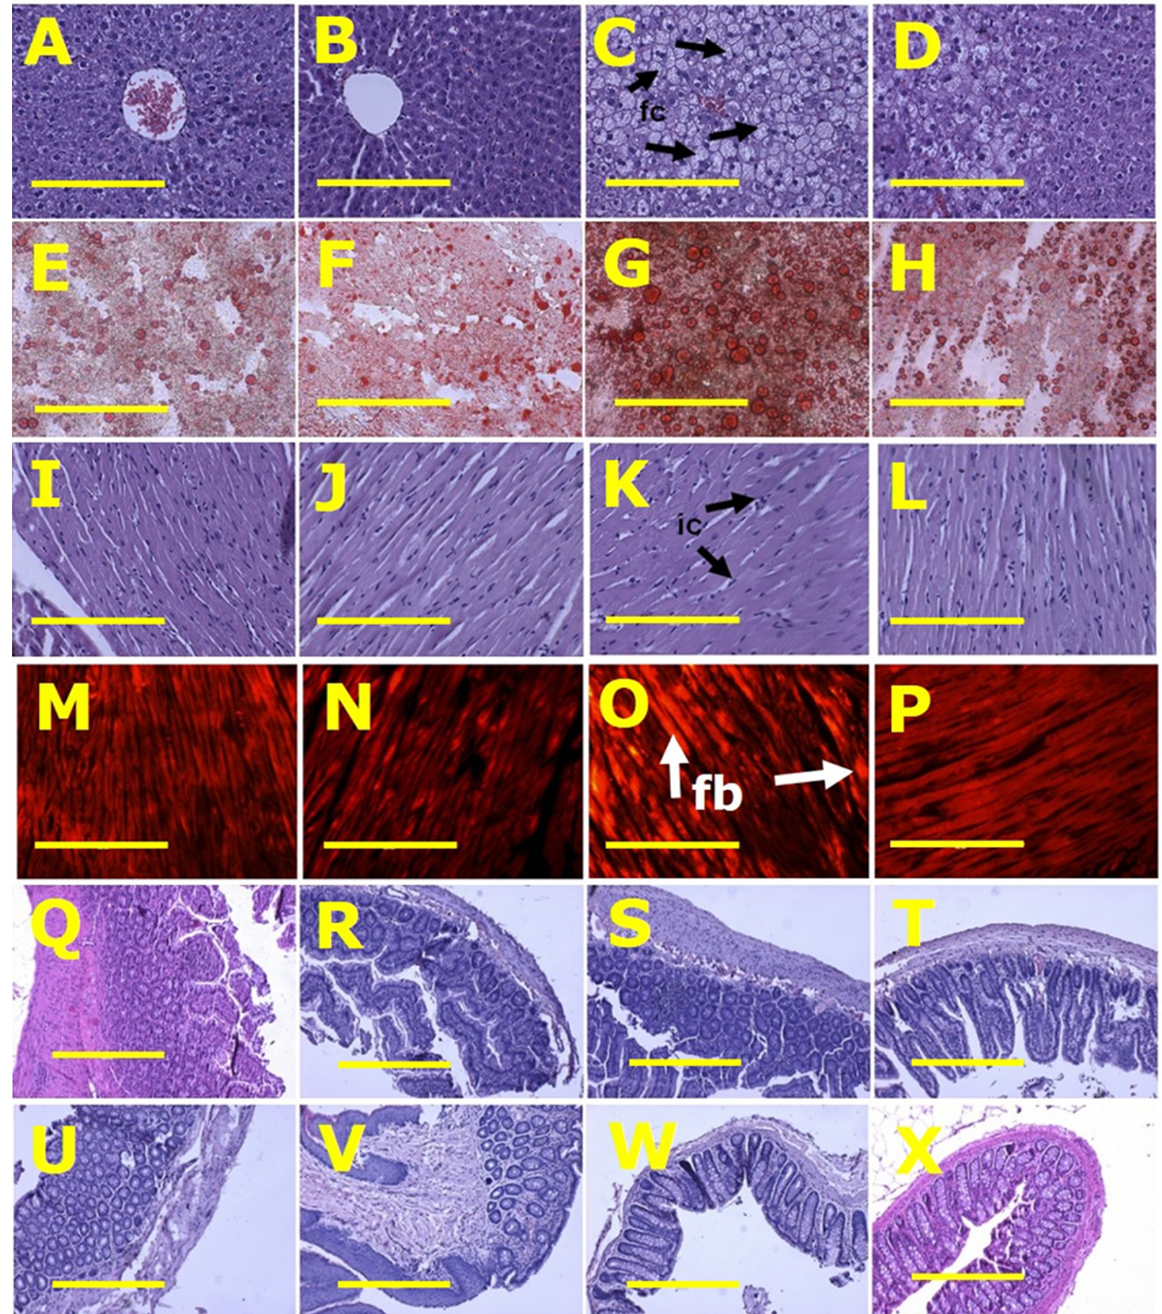
Figure 2. Histological analysis of liver, heart, ileum and colon. ( A – D ) showing haematoxylin and eosin staining; ( E – H ) showing oil red O staining to identify liver fat deposition; ( I – L ) showing haematoxylin and eosin staining to identify heart inflammation; ( M – P ) showing picrosirius red staining to identify myocardial collagen deposition; ( Q – T ) showing haematoxylin and eosin staining of ileum; and ( U – X ) showing haematoxylin and eosin staining of colon in rats fed with corn starch diet ( A , E , I , M , Q , U ), rats fed with corn starch diet + Nannochloropsis oceanica ( B , F , J , N , R , V ), rats fed with high-carbohydrate, high-fat diet ( C , G , K , O , S , W ) and rats fed with high-carbohydrate, high-fat diet + Nannochloropsis oceanica ( D , H , L , P , T , X ). Fat cells = fc; inflammatory cells = ic; collagen = fb. Scale bar is 200 µm for ( A – P ) (20×) and 100 µm for ( Q – X ) (10×).